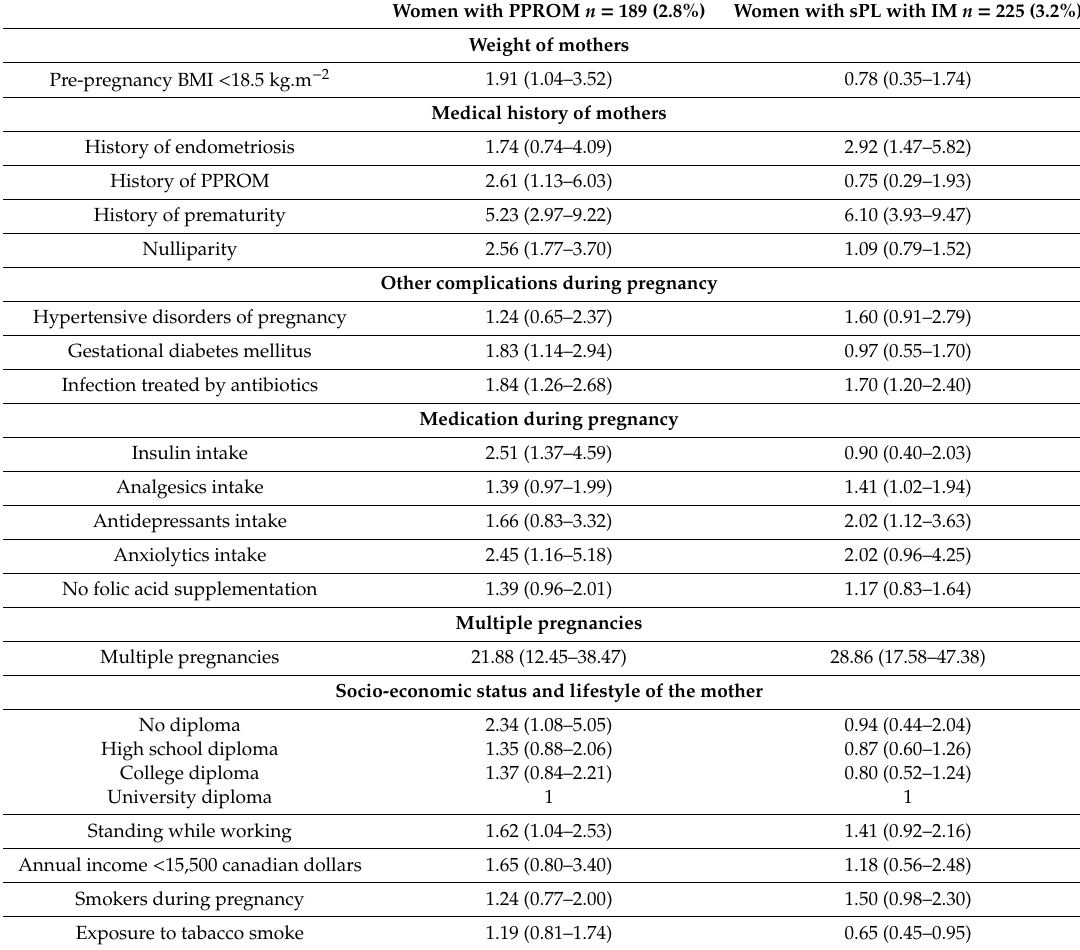
Table 2. Risk factors of preterm premature rupture of membranes (adjusted odds ratio). Women with PPROM n = 189 (2.8%) Women with sPL with IM n = 225